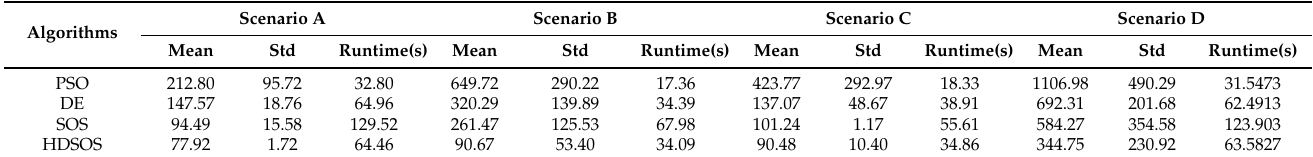
Table 1. Performance of algorithms in two-dimensional scenarios (30 runs).